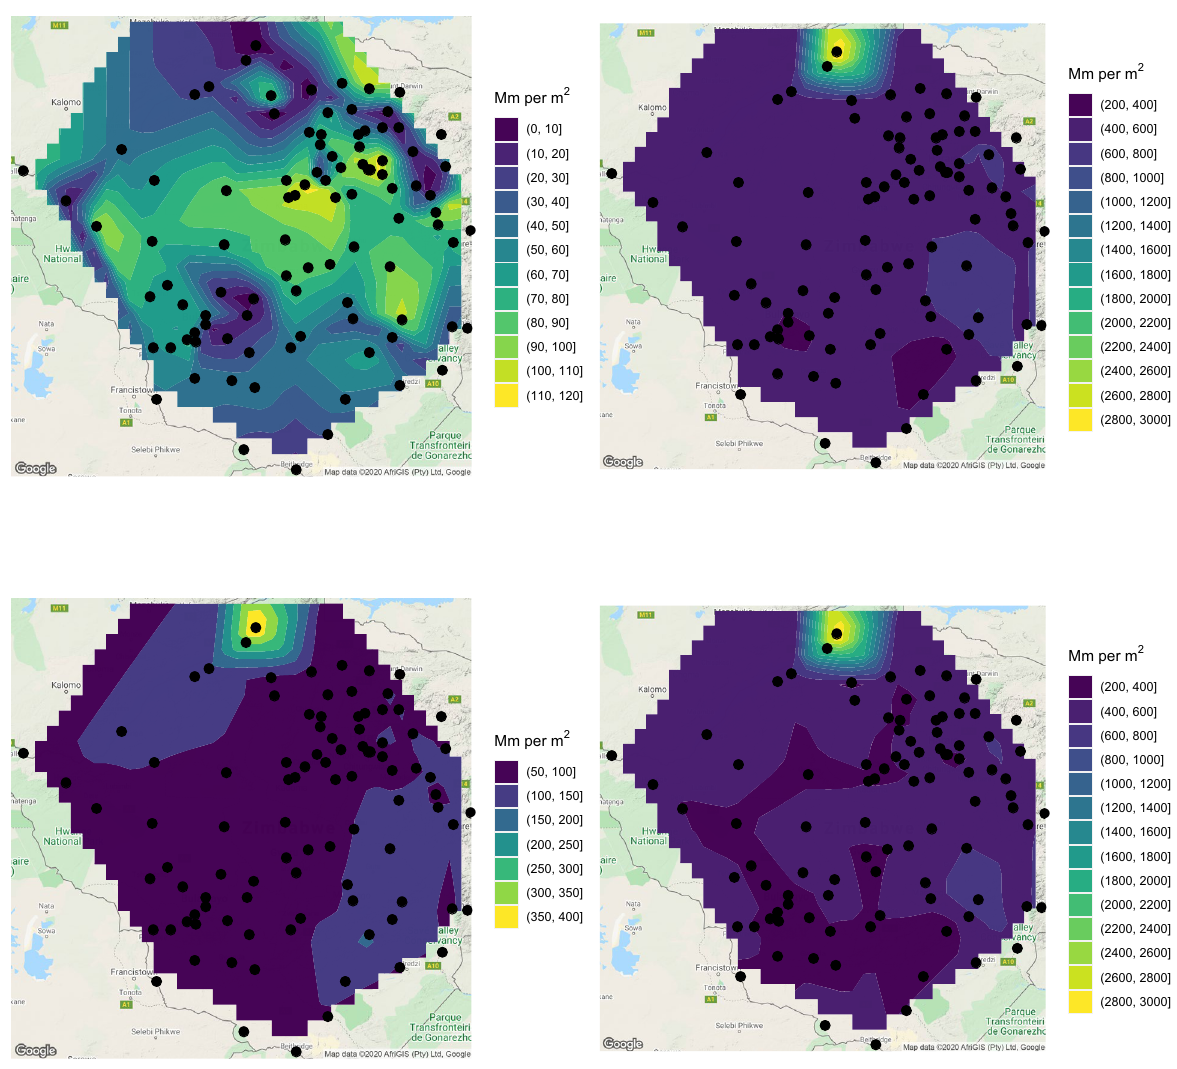
Figure 3. Minimum (top left), maximum (top right), standard deviation (bottom left) and range (bottom right) of the annual highest monthly rainfall in Zimbabwe. ggplot2 version 3.3.5, https:// cran.r- proje ct. org/ web/ packa ges/ ggplo t2/ index. html was used for